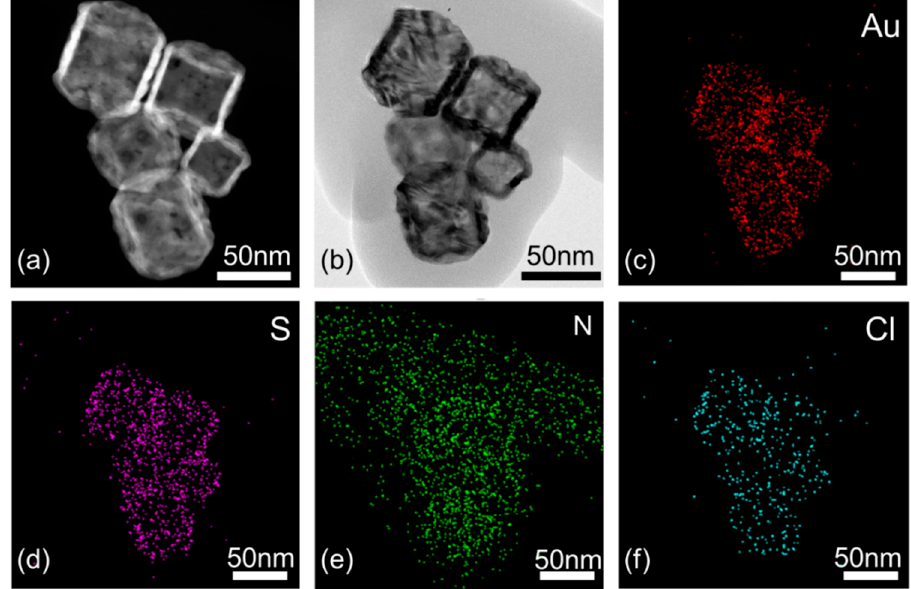
Figure 3. ( a ) STEM image, ( b ) TEM image and ( c – f ) elemental mapping of Au, S, N, and Cl AP3-AuNCs.